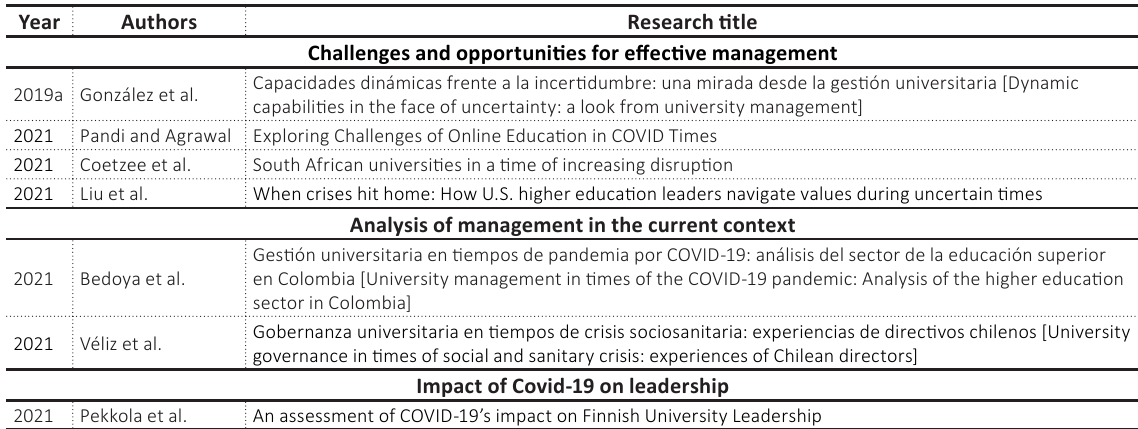
Table 3. Research studies on management and leadership in times of